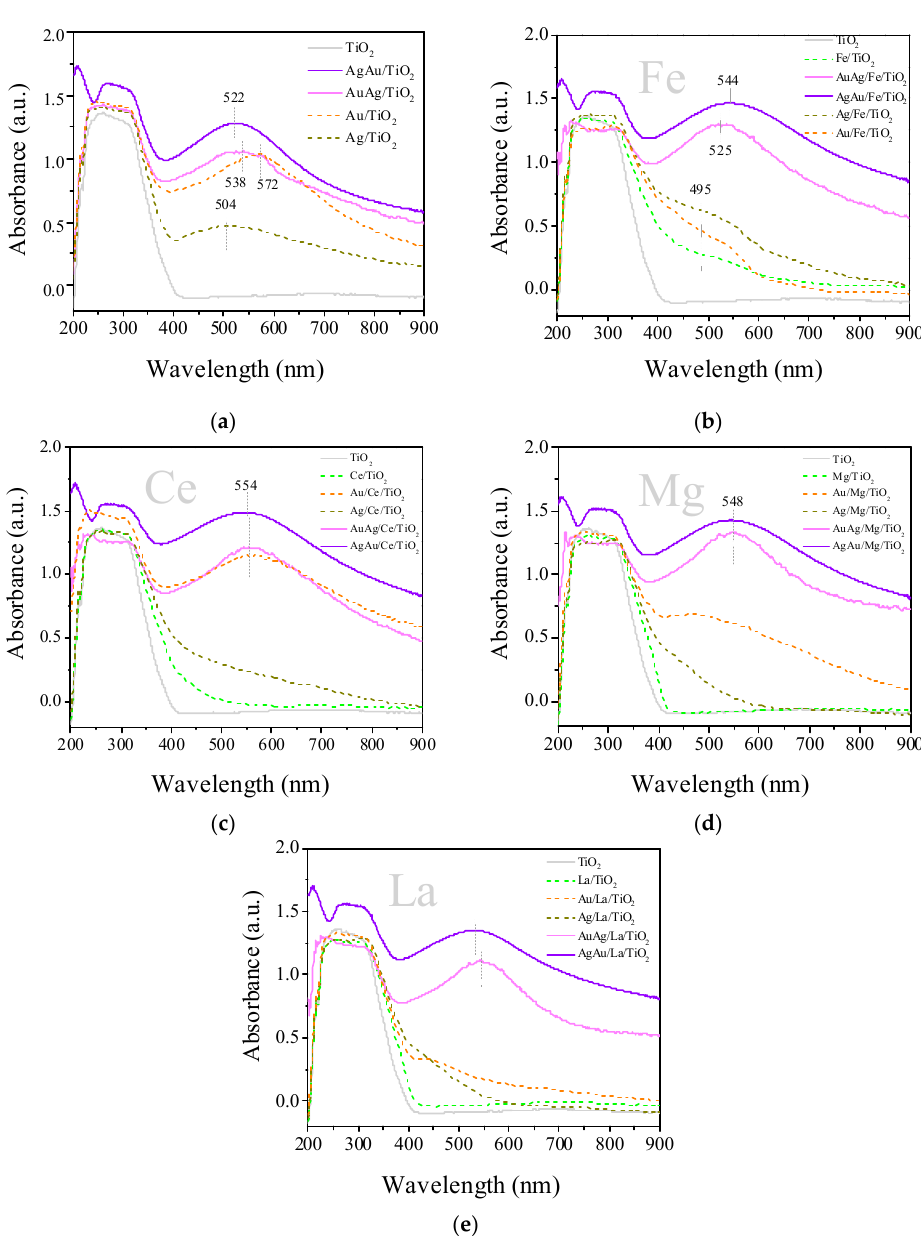
Figure 3. Diffuse reflectance UV–vis spectra of samples on different supports: TiO 2 ( a ), Fe/TiO 2 ( b ), Ce/TiO 2 ( c ), Mg/TiO 2 ( d ) and La/TiO 2 ( e ). Samples were studied after reduction in H 2 at 300 °C for 1 h. Previously reported data for Au/M/TiO 2 catalysts are reprinted from [39,40] (copyright 2004), with permission from Elsevier. Data for Ag/M/TiO 2 were adapted from [63].